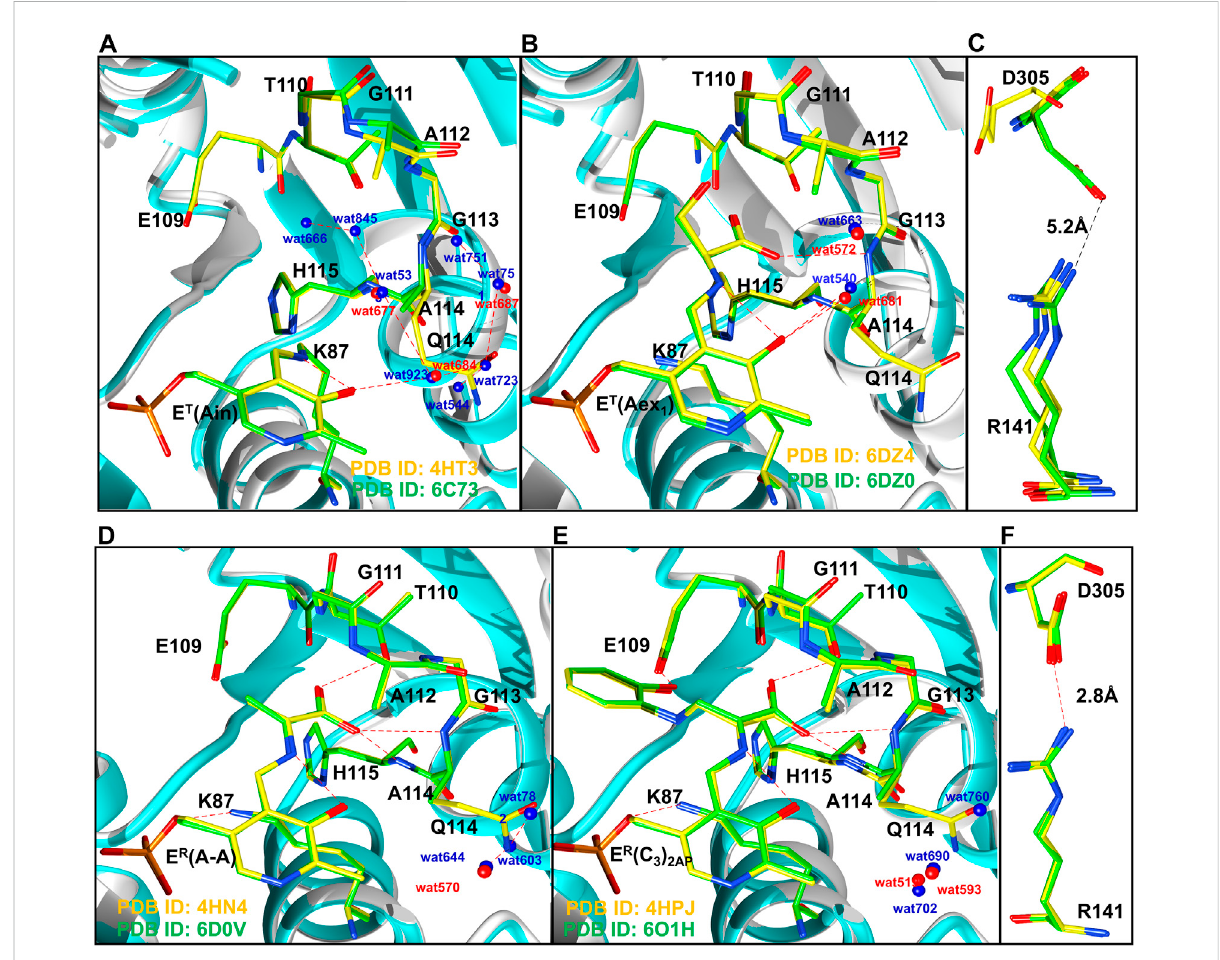
FIGURE 9 Comparison of T state (A,B) , and R state (D,E) conformations of TS intermediates. (A) wild-type (PDB ID: 4HT3, 6DZ4) and β Q114A (PDB ID: 6C73, 6DZO) internal aldimine and (B) external aldimine complexes. Coloring scheme: wild-type, yellow carbons and red waters; β Q114A, green carbons and blue waters. Wild-type ribbons gray, β Q114A ribbons, teal. (A) : Comparisons of wild-type and β Q114A internal aldimines. (B) : Comparisons of wild-type and β Q114A TS external aldimines. (C) : The β R141 and β D305 residues in the T state (open) complex of the β subunit are too distant to form an H-bonded salt bridge in E(Ain and E(Aex 1 )complexes. (D) Comparison ofwild-type and β Q114A E(A – A). (E) Comparison of wild-type and β Q114A E(C 3 ) 2AP . (F) β R141- β D305 salt bridges found in E(A – A) and E(C 3 ) 2AP . Figure redrawn from Ghosh et al.